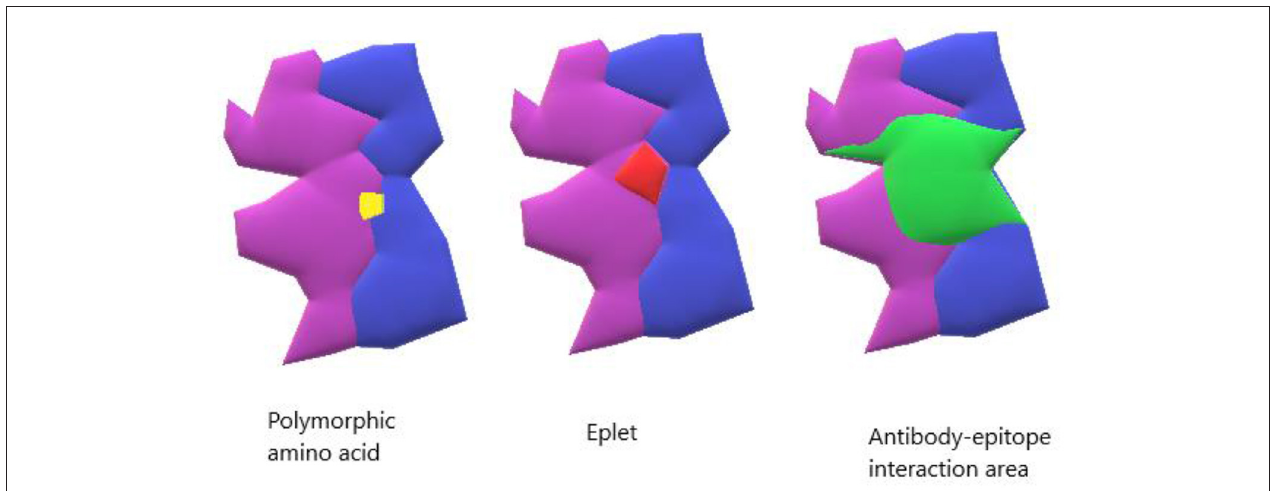
FIGURE 1 | Model of HLA binding groove. The yellow shows a single polymorphic amino acid change. The red shows an antibody-verified eplet. The green shows the entire antibody interaction area which can contain the surface area for antibody-epitope interaction.